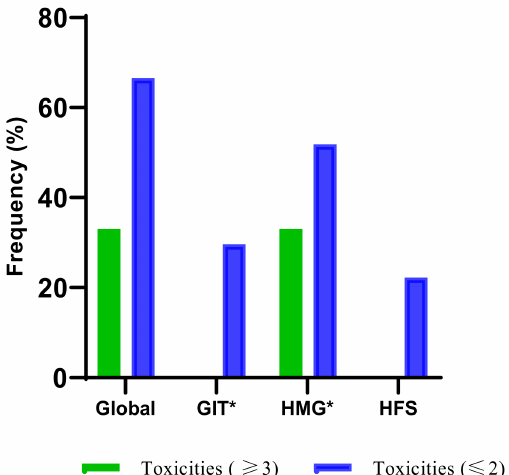
Figure 3. Plot of early fluoropyrimidine adverse events markers (GIT., HMG., HFS.) during the first two treatment cycles. (GIT., gastrointestinal; HMG., haematological; HFS., hand-foot-syndrome). Global includes all fluoropyrimidine-related AEs. GIT* Gastrointestinal markers include nausea, vom- iting, and diarrhoea. HMG* Haematological markers include neutropenia, leukopenia, thrombocy- topenia, and anaemia. In grades ≥ 3, this also includes dose reduction and treatment discontinuation. In grade ≤ 2, this does not include dose reduction and treatment discontinuation.